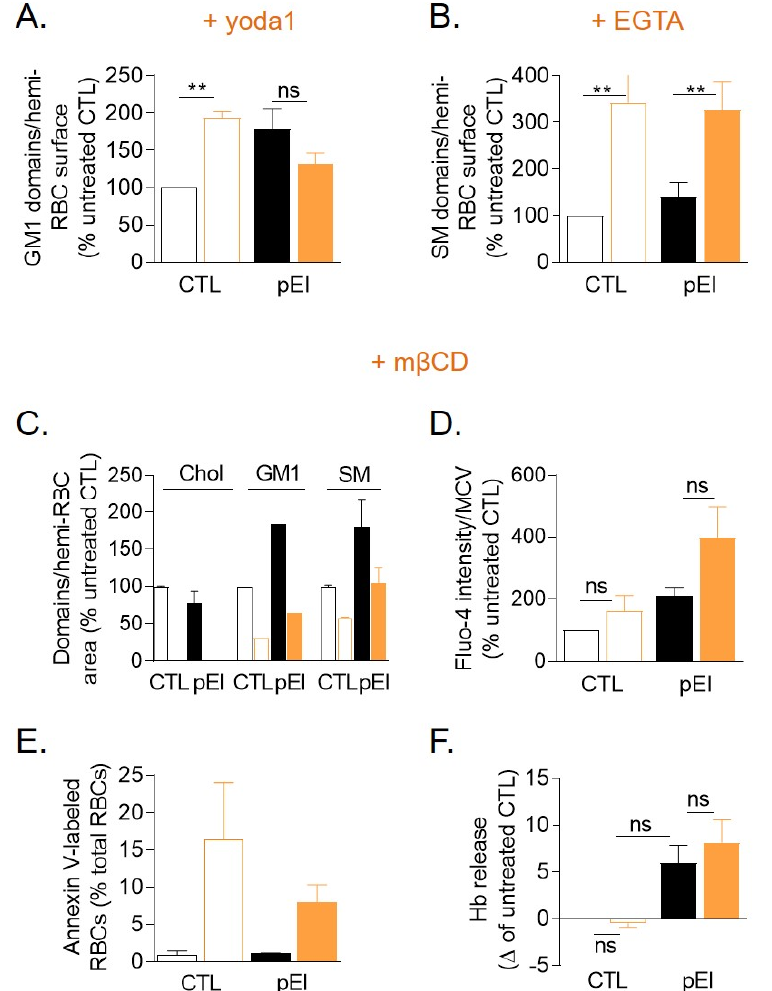
Figure 7. Lipid domains were altered for Ca 2+ exchange and cholesterol depletion worsened Ca 2+ accumulation. ( A,B ) Abundance of GM1- and sphingomyelin-enriched domains upon Ca 2+ influx stimulation ( A , addition of Yoda1 just after labeling) or Ca 2+ depletion ( B , incubation with EGTA). Data represent lipid domain abundance per hemi-RBC area and are means ± SEM from 3–7 independent experiments/lipid in which 300–600 RBCs were counted per condition in each experiment. Paired t tests to determine the effect of Yoda1 or EGTA on the abundance of lipid domains of the CTL and pEl. ( C – F ) Effect of cholesterol depletion through mβCD of lipid domains ( C ) on Ca 2+ accumulation ( D ), PS surface exposure ( E ) and hemolysis ( F ). ( C ) Abundance of lipid domains in RBCs pretreated with mβCD. Data are means ± SD/SEM of 2–4 independent experiments. ( D ) Intracellular Ca 2+ content measured in RBCs incubated with Fluo-4 AM and then with mβCD. Data are means ± SEM of 6 independent experiments. Wilcoxon matched-pairs signed rank tests. ( E ) Surface exposition of phosphatidylserine (PS) evaluated by flow cytometry with Annexin V-FITC on mβCD-treated RBCs. Data are means ± SD of 2 experiments. ( F ) Hemoglobin release in the supernatant measured after incubation with mβCD and expressed as delta of hemolysis detected for the untreated CTL. Data are means ± SEM of 3 independent experiments. Mann-Whitney test for comparison of CTL vs . pEl and Wilcoxon matched-pairs signed rank tests for the effect of mβCD. ns, not significant; **, p < 0.01